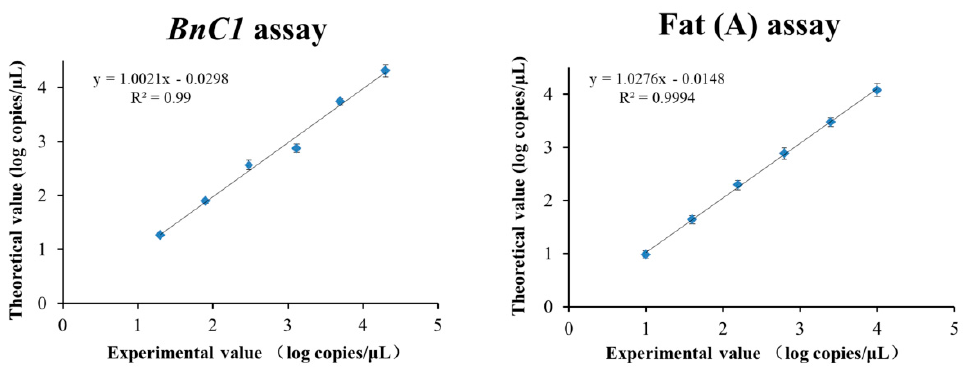
Figure 3. Dynamic range and correlation between experimental copy numbers with assigned copy numbers of BnC1 and BnAcc assays. The average data of three independent experiments are repre- sented (R 2 values for BnC1 and BnAcc are 0.99 and 0.9994, respectively).